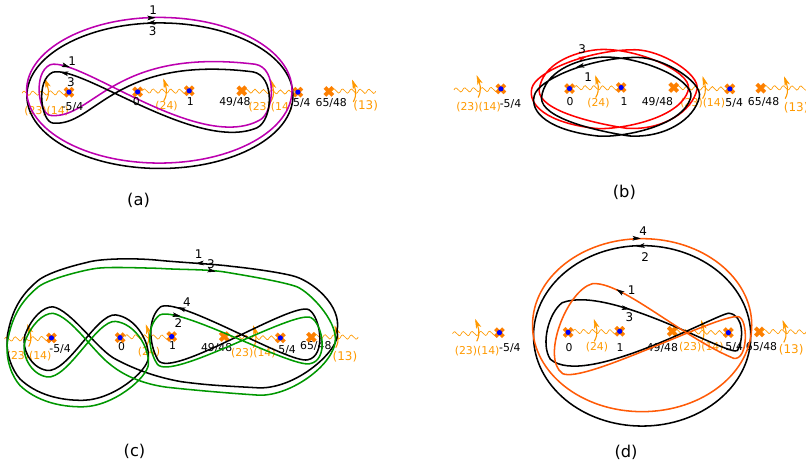
Figure 5 . Basis vectors for the EM charge lattice in the doubled SU(2) N f = 4 theory, realized as homology classes on the Seiberg-Witten curve Σ . These charges have −h γ −h γ c , γ b i = h γ b , γ c i = 8 . We set f = 5 / 16 , f 0 = 5 / 4 , u = 1 , u 0 = 3 . The poles are at z = − 5 / 4 , 0 , 1 , 5 / 4 , and there are two other branch points at z = 49 / 48 and z = 65 / 48 . We construct the cycles with λ → − λ symmetry; thus for each strand on sheet i , there is a strand on sheet i + 2 mod 4 going in the opposite